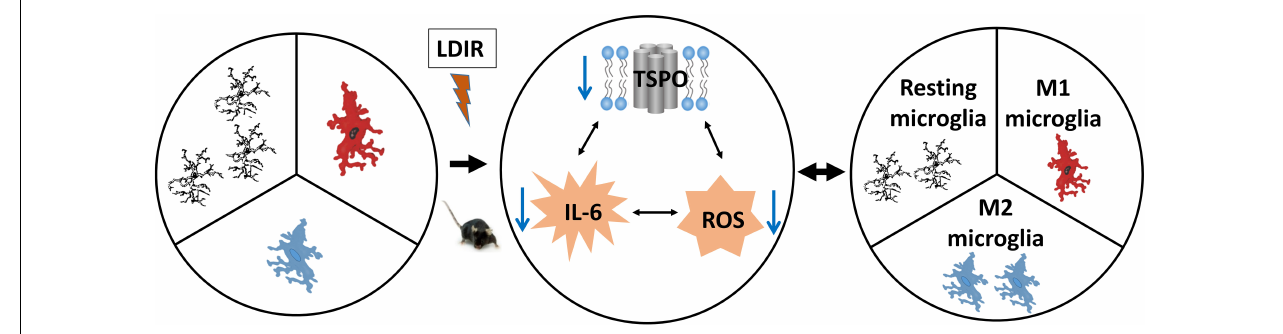
FIGURE 6 | Low-dose ionizing radiation (LDIR) alters the microglial functional states by modifying levels of cytokines and ROS. LDIR decreases levels of TSPO, IL-6 and reactive oxygen species (ROS), which subsequently reduces the interaction among them, resulting in an increased ratio of polarized M2 microglia. The increased M2 microglia produce less pro-inflammatory cytokines (e.g., IL-6) and ROS while producing more anti-inflammatory cytokines (e.g., IL-10) and